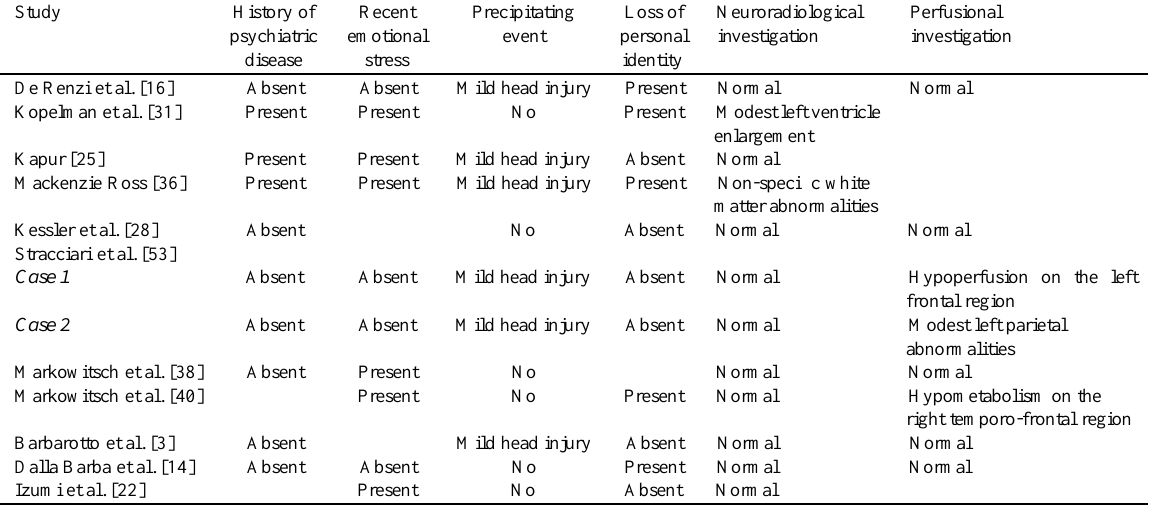
Table 1 Clinical and neuroradiological data in a selection of cases of psychogenic amnesia from the literature